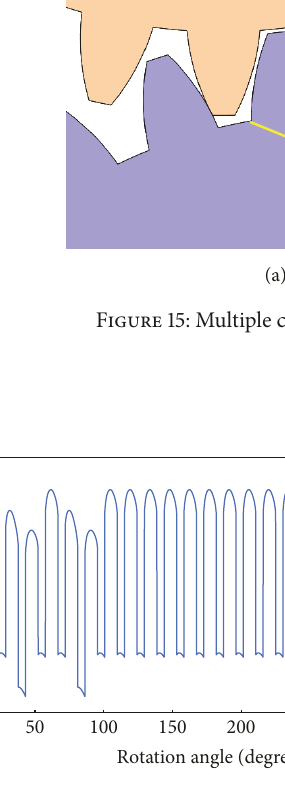
Figure 18: The gear mesh stiffness for the third scenario (four non- consecutive cracked teeth with CLPs of 20%, 15%, 10%, and 5%).